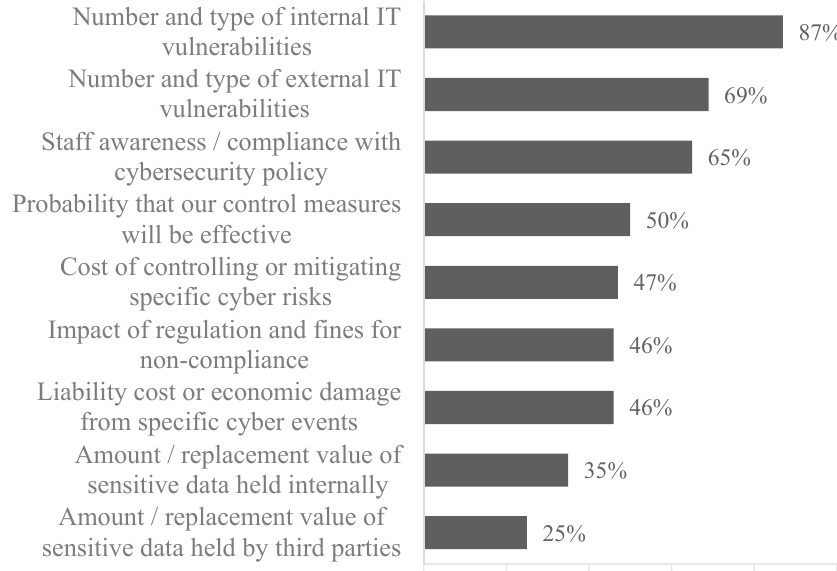
Figure 2. Key factors measuring the level of cyber risks according to “The Marsh Microsoft 2019 Global Cyber Risk Perception Survey” (September 2019).